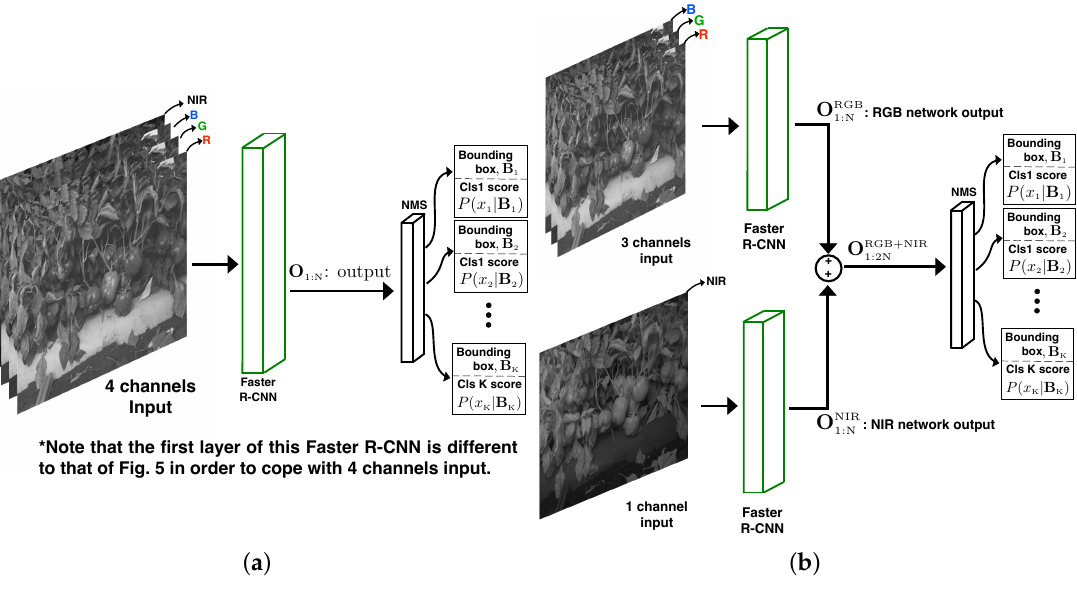
Figure 6. A diagram of the early and late fusion networks. ( a ) The early fusion that concatenates a 1-channel NIR image with a 3-channel RGB image; ( b ) The late fusion that stacks outputs, O RGB+NIR , 1:2 N from two Faster R-CNN networks. O RGB and O NIR represent the output containing N = 300 bounding 1: N 1: N boxes and their scores from the RGB and NIR networks, respectively. K is the number of objects being detected. Note that the Faster R-CNNs of the early fusion are identical to that of Figure